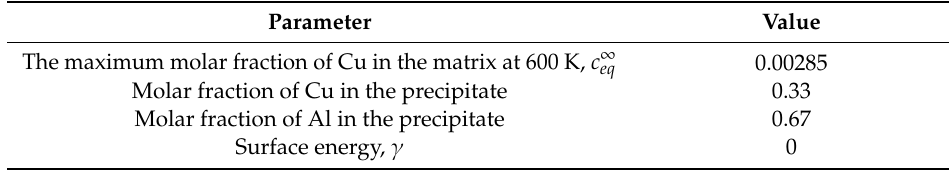
Table 2. Thermodynamic variables used in the